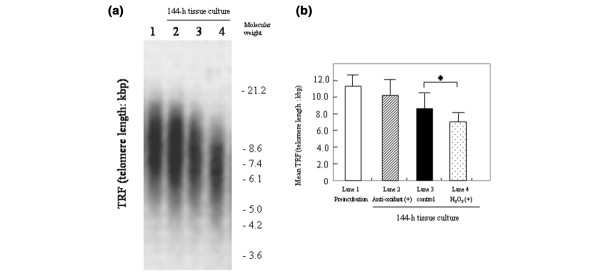
Telomere length of cultured chondrocytes from tissue cultured cartilage explants under the different oxidative conditions. After 144 hours' incubation of tissue culture, chondrocytes were isolated from cartilage explants, which were incubated in the presence or absence of H2O2 (0.1 μmol/l) or ascorbic acid-2-O-phosphate (Asc2P; 100.0 μmol/l). Telomere lengths in chondrocytes (1 × 106chondrocytes of passage 3–4 after isolation) were determined using the terminal restriction fragment (TRF) assay. (a) Representative image of telomere length assay of chondrocytes after 144 hours of incubation. Lane 1, pretreated group (telomere length of isolated chondrocytes from cartilage explants before tissue culture); lane 2, Asc2P + H2O2 treated group; lane 3, control group; lane 4, H2O2 treated group. (b) Treatment with Asc2P (lane 2) showed a tendency to elongate the mean telomere length of chondrocytes in comparison with control. Mean telomere length in H2O2 treated group was significantly shorter than in the control group (n = 9; P < 0.05).